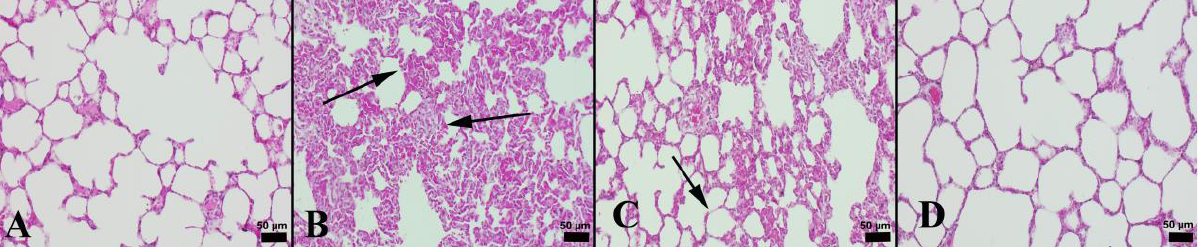
Figure 1. Histopathological appearance of the lungs in study groups: ( A ) normal microscopical appearance in lungs in a rat belonging control group; ( B ) marked increase in septal tissue thickness (arrows) in lungs in a rat from LPS group; ( C ) marked amelioration and decreased septal tissue thickness (arrow) in a rat in LPS + NBL group; and ( D ) normal lung tissue architecture in a rat belonging NBL group, H&E, scale bars = 50 µm.